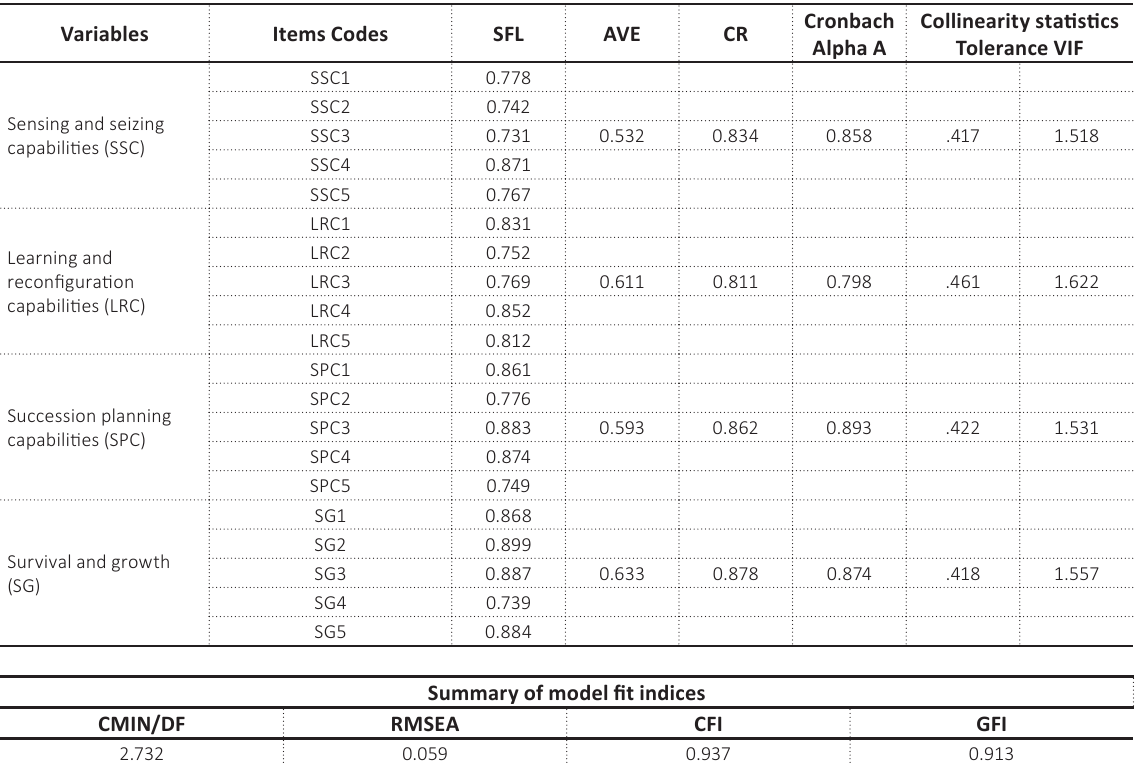
Table 2. Results for the factor structures of the measurement instrument